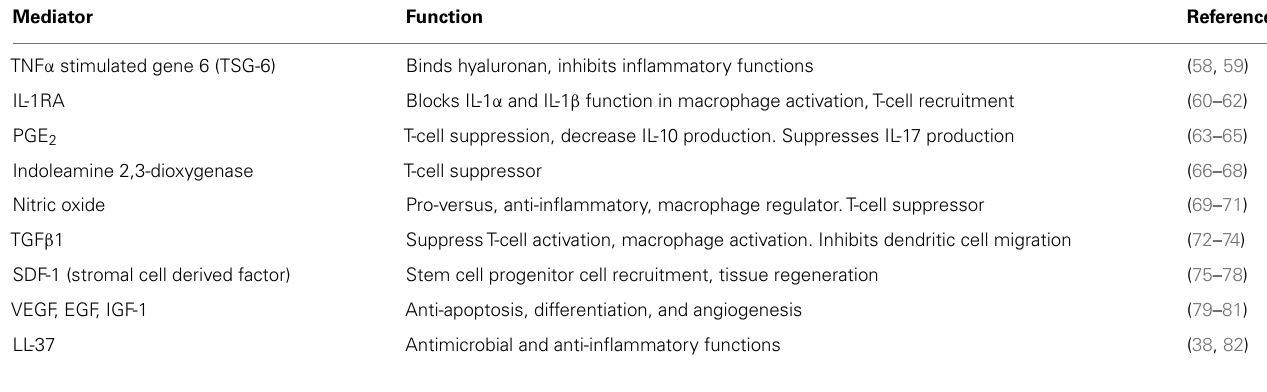
Table 1 | Mesenchymal stromal cells and paracrine factors of inflammation. Mediator